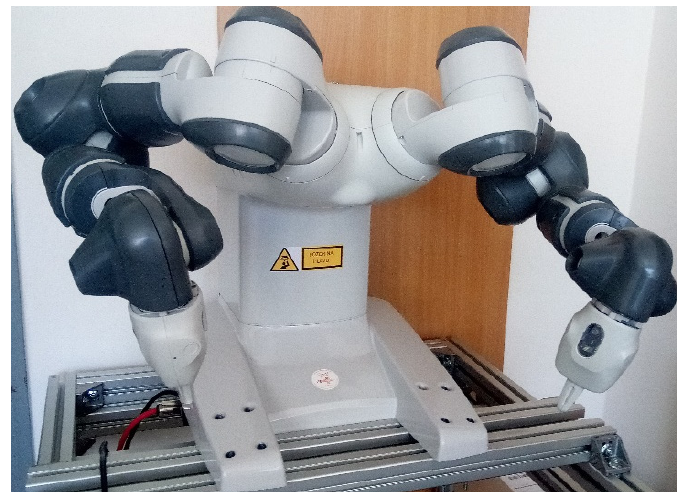
Figure 1. A two-armed YuMi robot.